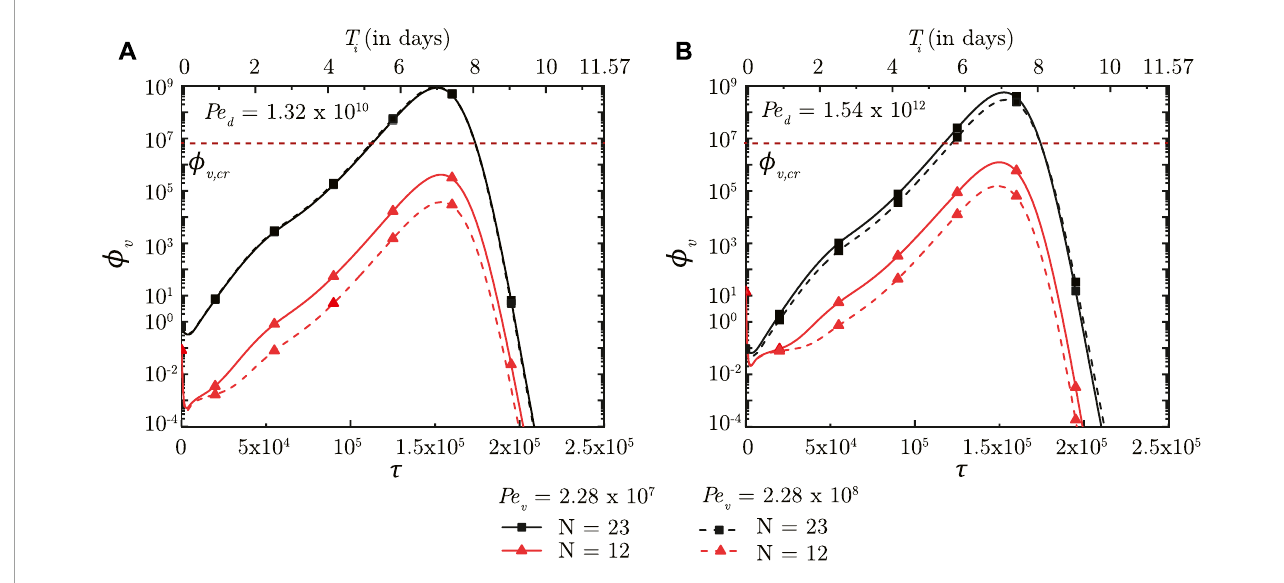
FIGURE 5 Temporal change in dimensionless virus concentration ( ϕ v ) in the upper airways ( N = 12 ) and the deep lung ( N = 23 ) for different Pe v with respect to dimensionless time ( τ ) as well as a dimensional time ( T i ) post infection onset. The breathing time period ( T b = 4s) is considered for obtaining the dimensional time (see Eq. 7 ). The results are shown for two different Pe d in (A,B) . The dotted line indicates the critical viral load ( ϕ v , cr ) in the deep lung required for pneumonia onset (Fajnzylber et al., 2020; Wölfel et al., 2020).